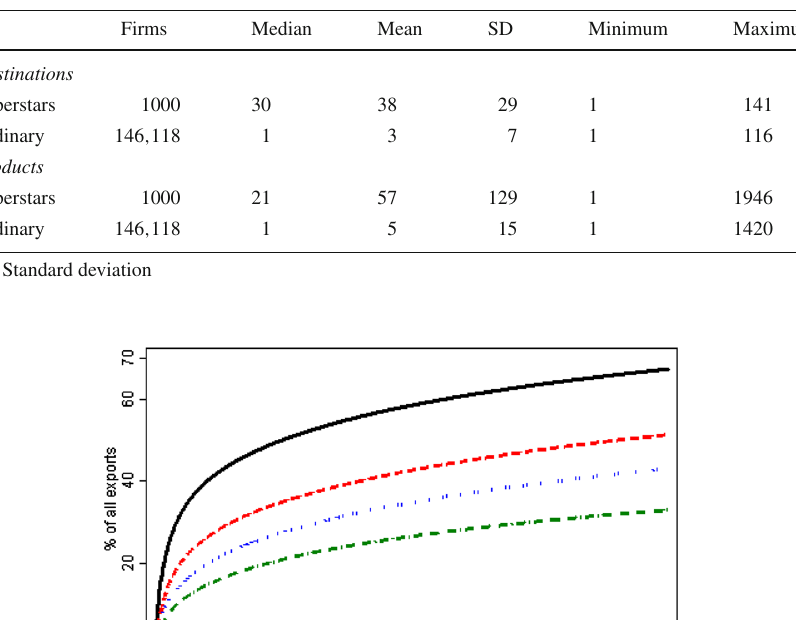
Table 4 Superstar exporters versus ordinary exporters, 2015. Source: Own calculations, based on the Customs database